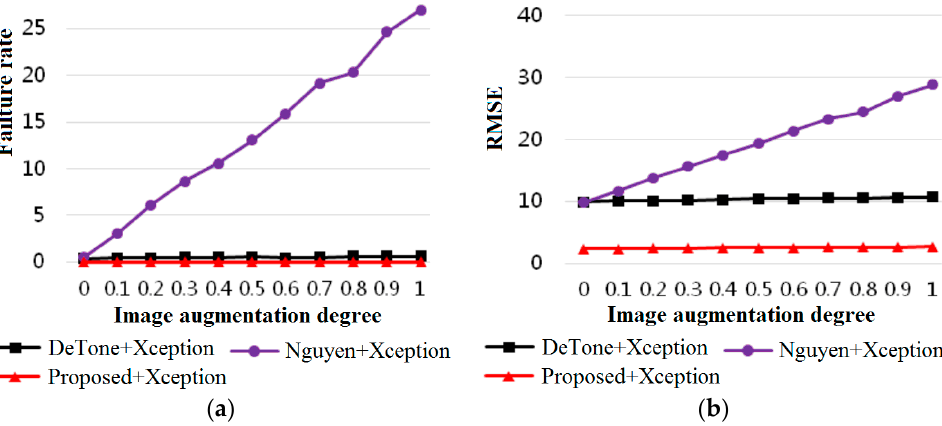
Figure 5. Robustness of DeTone’s algorithm, Nguyen’s algorithm and the proposed algorithm using